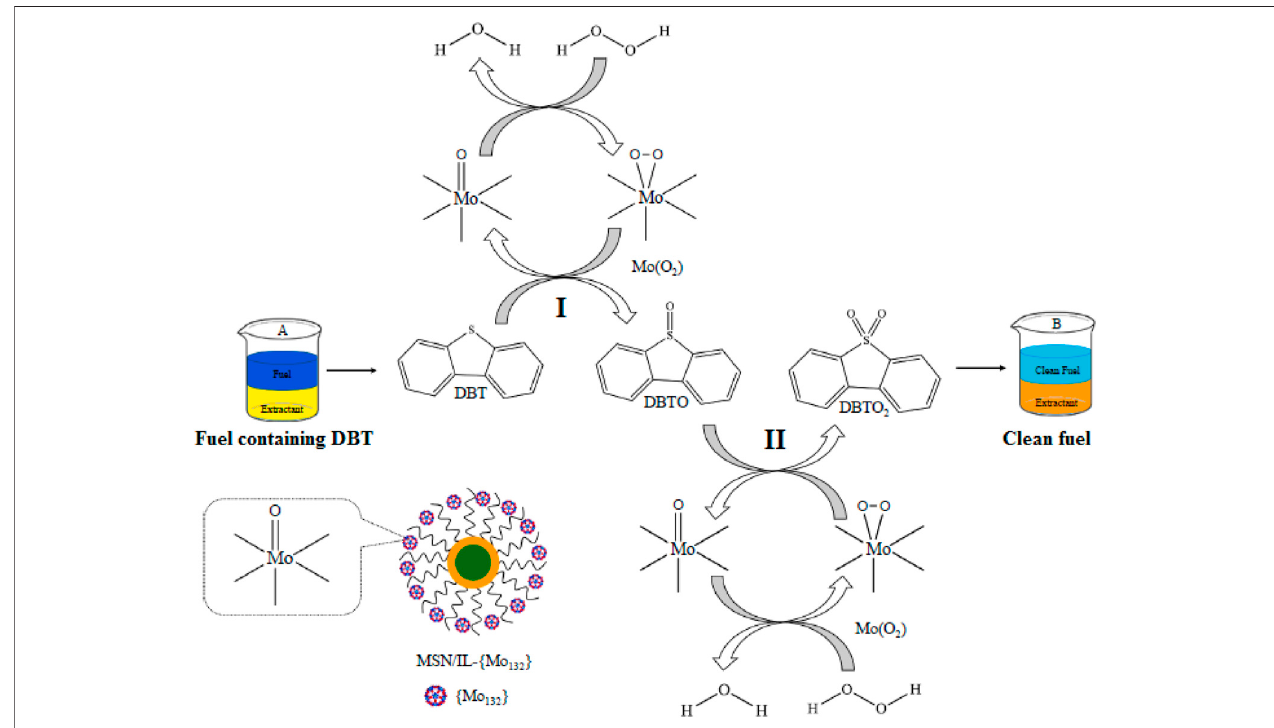
FIGURE 1 | Catalytic oxidation of DBT using H 2 O 2 over MSN/IL-(Mo132) catalyst (A) before and (B) after the ODS process (Mojaverian Kermani et al., 2021).